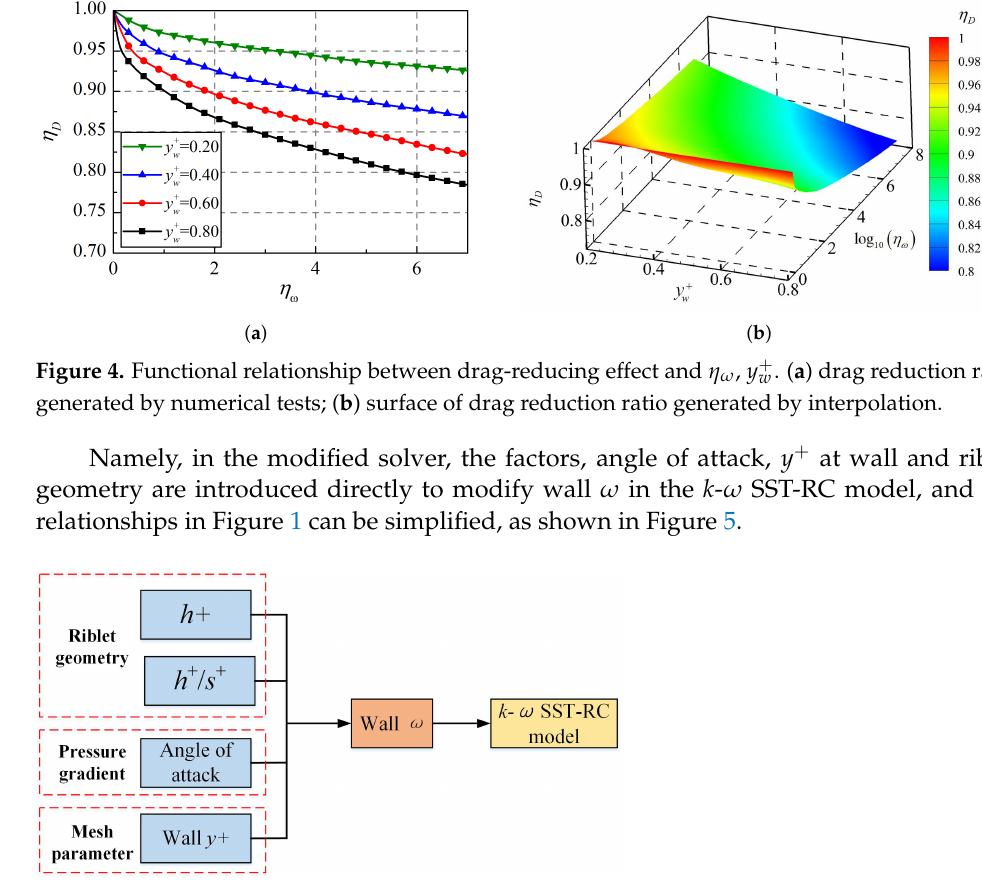
Figure 5. Schematic picture of the simplified relationship among the parameters.